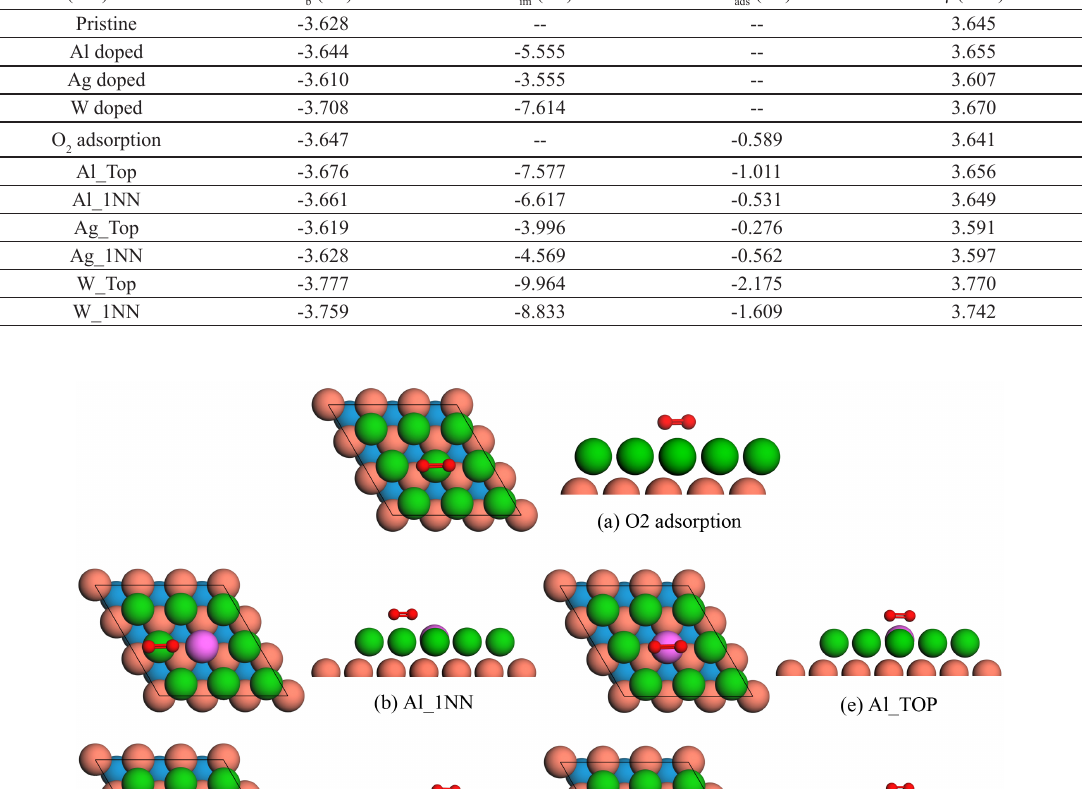
Table 1. The calculated the doping energy ( E and O adsorption Cu surface. 2